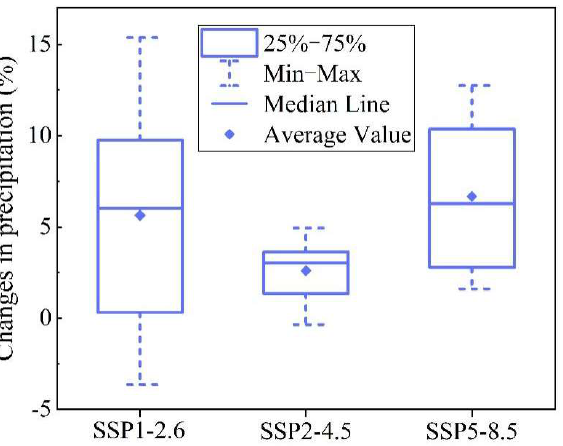
Figure 8. The box−plot of precipitation changes in 6 GCMs relative to the baseline period under the SSP1-2.6, SSP2-4.5, and SSP5-8.5 climate scenarios.